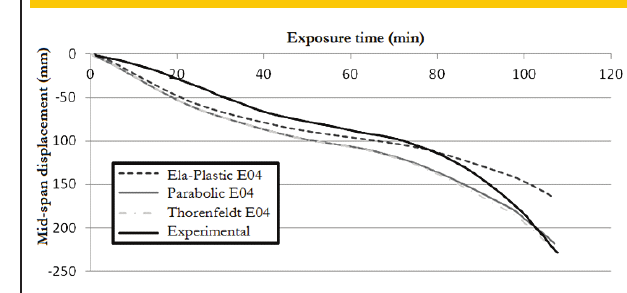
Figure 13 – Structural behavior in fire for the test with the 280 ASB 100 profile and full